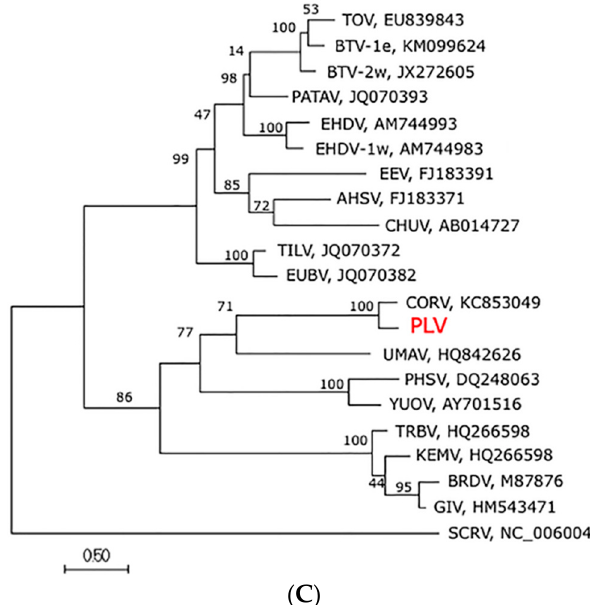
Figure 2. Phylogenetic analysis of orbivirus highly conserved genes. Maximum likelihood trees of highly conserved genes ( A ) VP1 (Pol); ( B ) T2 (subcore shell) and ( C ) T13 (outer core). Trees were constructed using a general time reversible model with gamma distribution and invariant sites (as determined by a jModelTest) with 1000 replicates. “e” and “w” denotes eastern and western isolates respectively. Accession numbers are denoted next to each virus. PLV accession numbers: KU724110-KU724119.